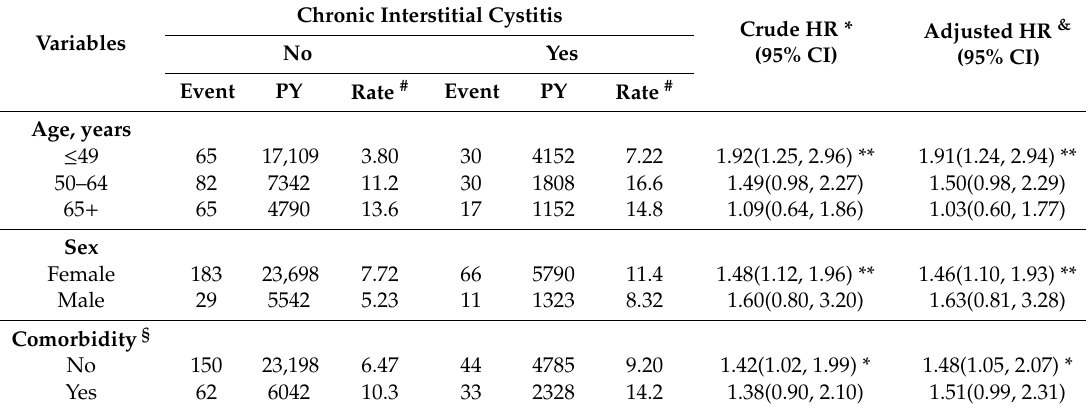
Table 3. Incidence of herpes zoster by age, sex and comorbidity and Cox model measured hazards ratio for patients with chronic interstitial cystitis compared those without chronic interstitial